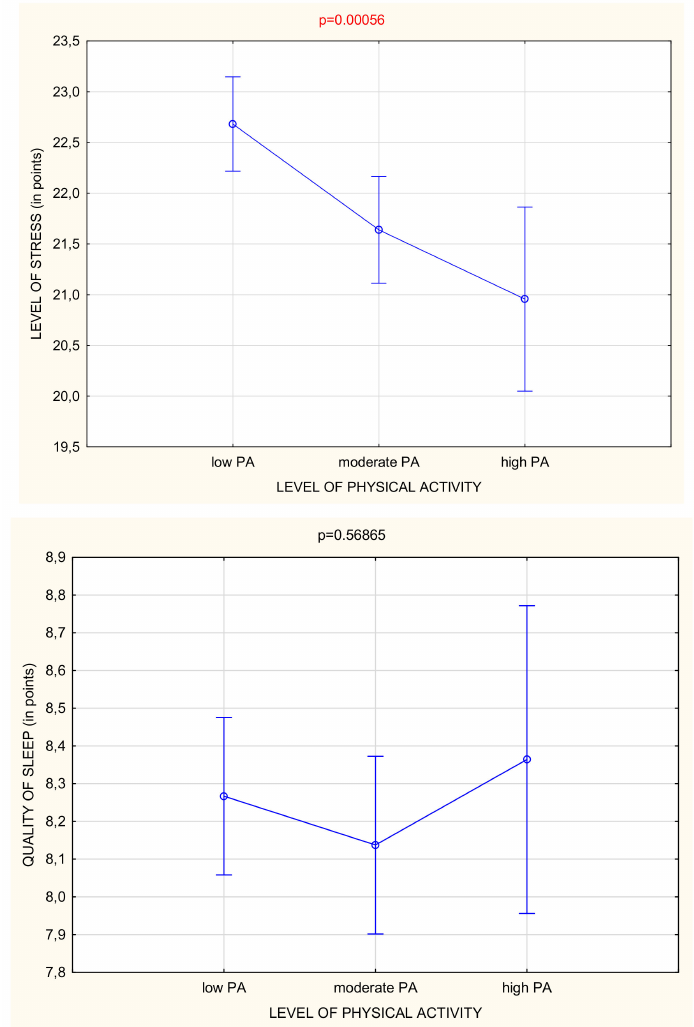
Figure 3. Level of stress and quality of sleep depending on the level of